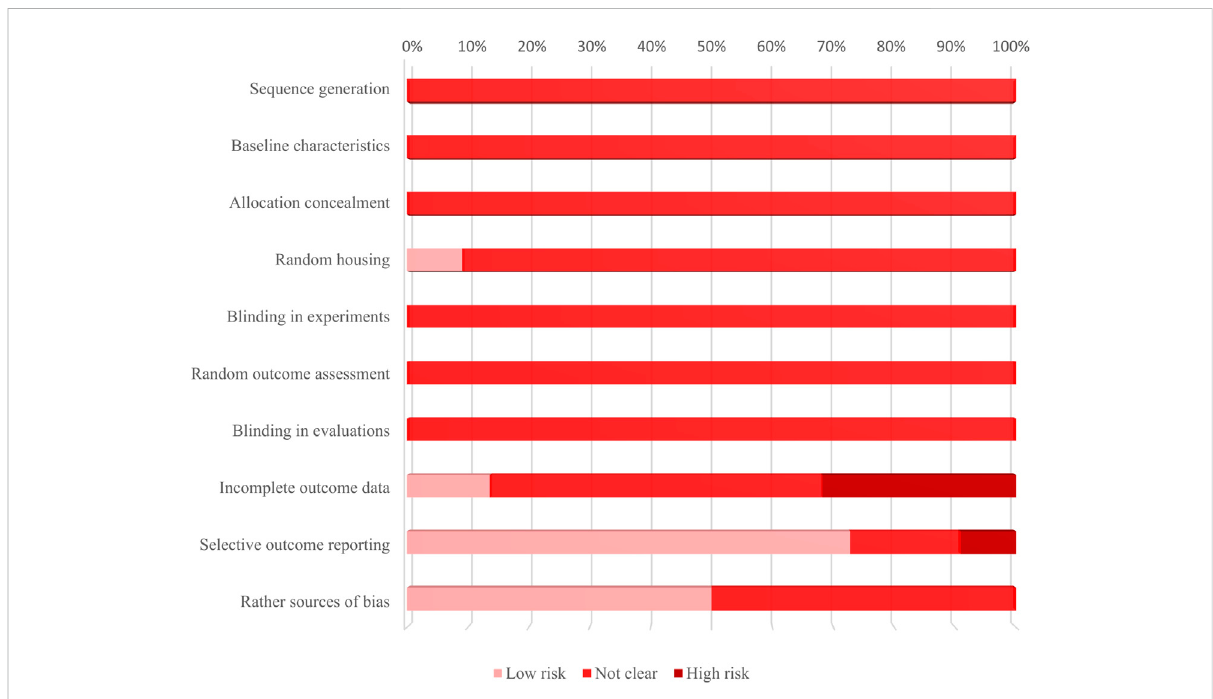
FIGURE 4 Results of the evaluation bias risk of 22 included studies applying SYRCLE ’ s RoB tool. The bar graph shows the percentage frequencies of 10 sources of bias. It is to be noted that the main sources of bias are “ incomplete outcome data ” and “ selective outcome reporting.